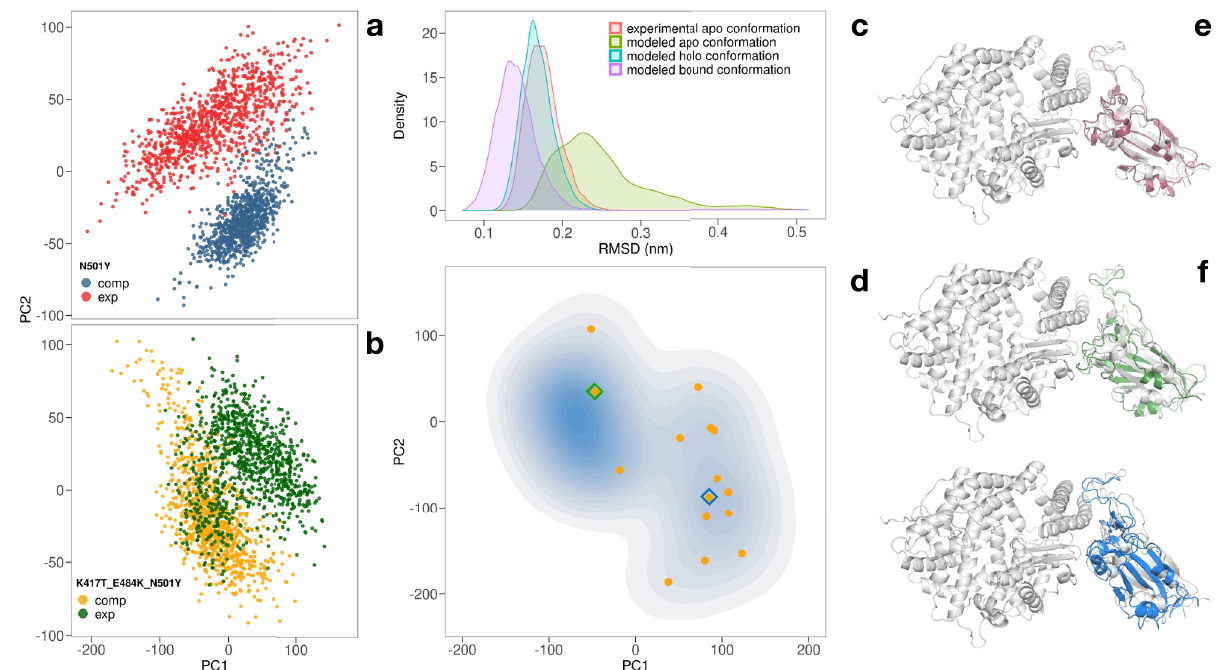
Fig. 2 Comparison between experimental and modeled SARS-CoV-2 Spike-Ace2 complexes. a Comparison between the molecular dynamics simulation of the experimental and computationally-obtained complex of the English variant of SARS-CoV-2 spike protein bound to ACE2 receptor. Snapshots of the spike protein are projected in the plane of the two major components of the covariance matrix obtained from a principal component analysis (PCA) over the position covariance matrix. b Same as in panel ( a ) but for the SARS-CoV-2 ’ s Amazonian variant. c Distribution of the root mean square deviation (RMSD)of the spike protein of the SARS-CoV-2 South African variant in apo and holo (bound to ACE2 receptor) forms. Fifty sampled frames of the spike protein from the computationally-obtained complex were used as references to evaluate the RMSD. d Probability density of fi nding a con fi guration of the apo spike protein in the plane identi fi ed by the two principal components of the covariance matrix. Colored dots represent the position of the con fi guration produced by the docking procedure when projected in the plane. e Cartoon representation of SARS-CoV2 spike frame extracted from the apo simulation having smallest RMSD. f Cartoon representation of two SARS-CoV2 spike-ACE2 complexes obtained from the docking